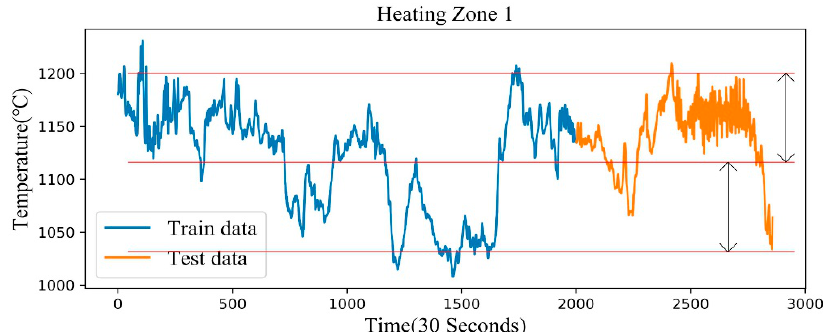
Figure 4. Training and test set distribution of the target variable in heating zone 1.